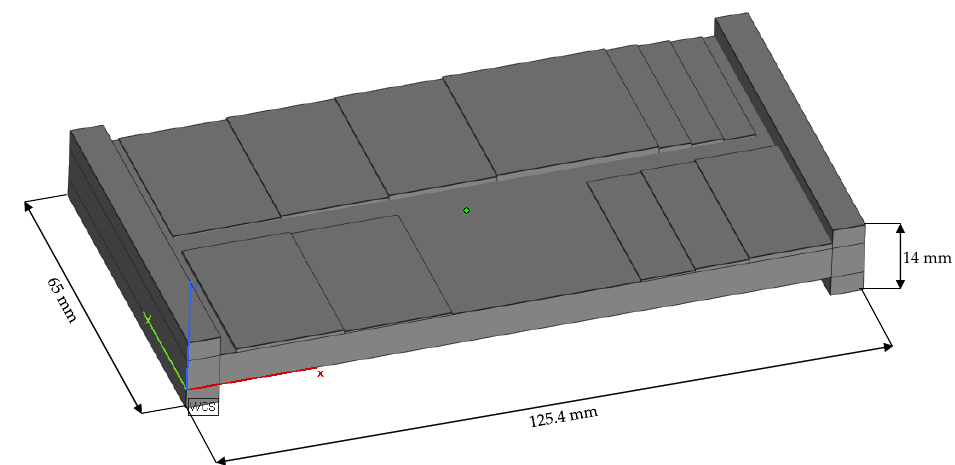
Figure 6. Grayscaled and dithered bitmaps printed for the parts in this work. ( a ) Upskin-series of bitmaps. ( b ) Downskin-series of bitmaps.